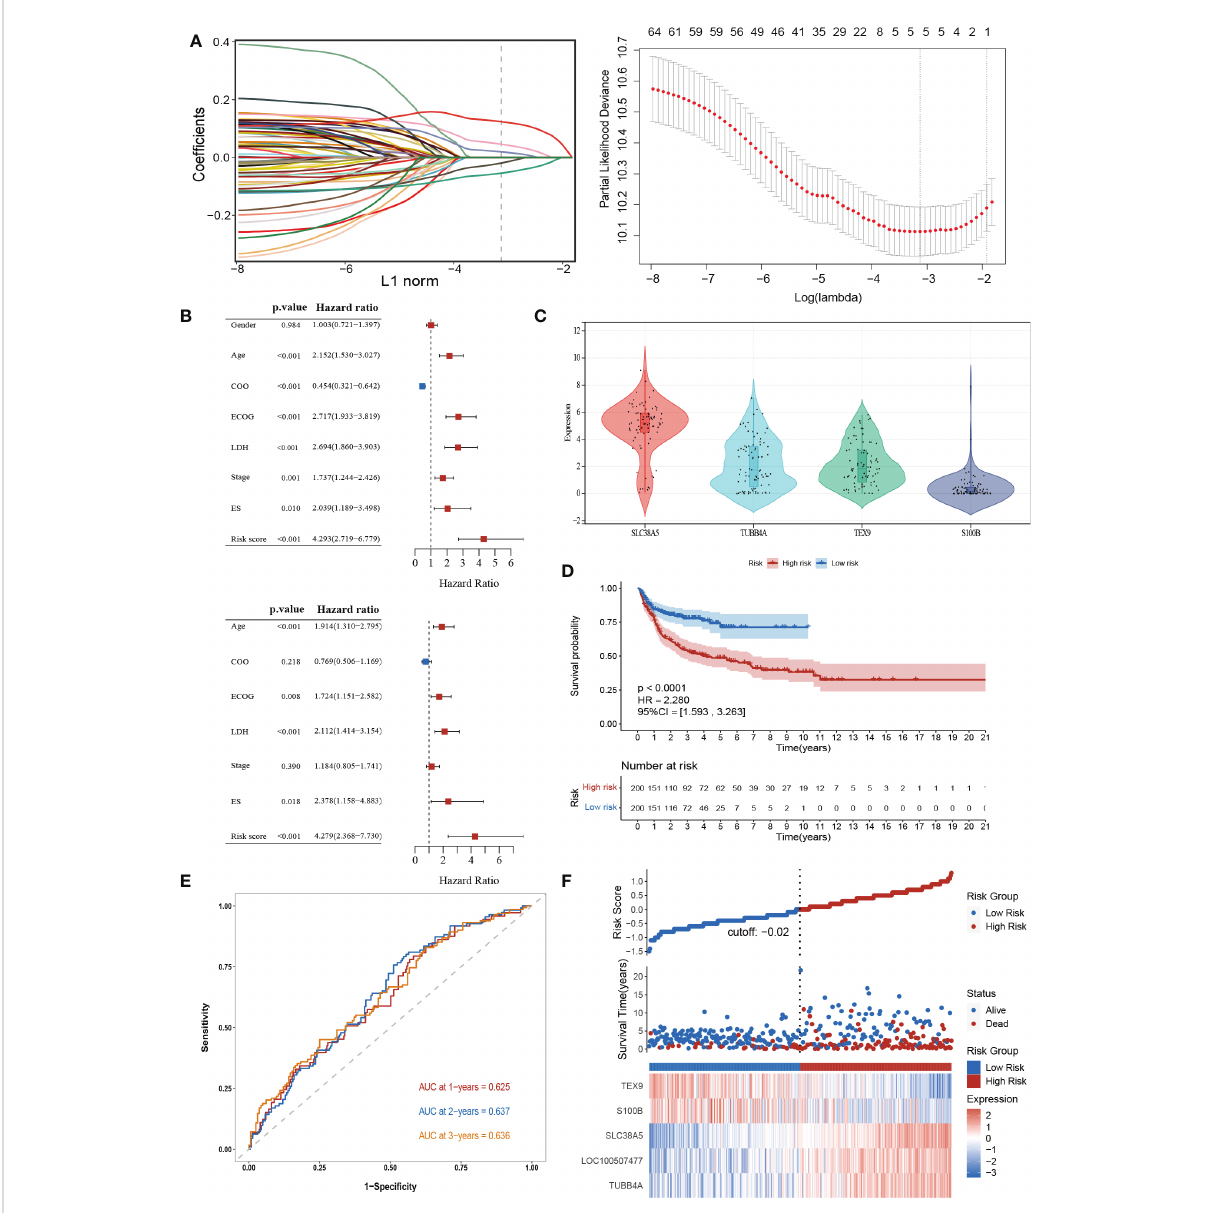
FIGURE 5 Construction and validation of the prognostic signature according to cuproptosis-related DEGs. (A) Construction of the prognostic model using LASSO Cox regression analysis. (B) Univariate and multivariate Cox regression analysis of clinical features and risk score in the training dataset. (C) Expression of the 4 genes in the CCLE database. (D) Kaplan-Meier curve in the high- and low-risk group. (E) Sensitivity and speci fi city of the risk score model assessed by time-dependent ROC analysis. (F) Ranked dot and scatter plots showing the risk score distribution and patients ’ survival status. LASSO, the Least absolute shrinkage and selection operator; ROC, receiver operating characteristic. LDH, lactate dehydrogenases; ES, extranodal sites; ECOG, The Eastern Cooperative Oncology Group performance